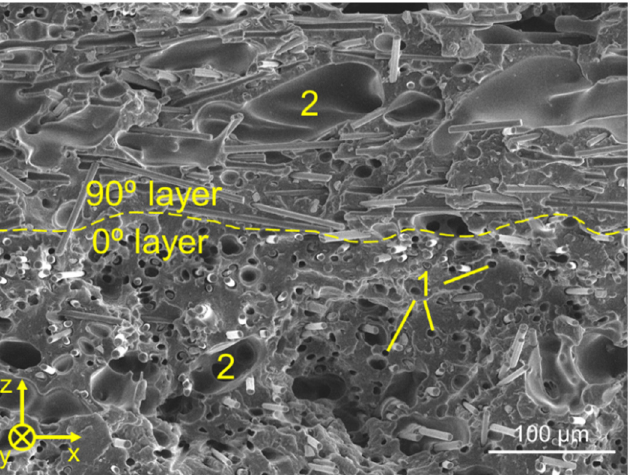
Figure 12. General appearance of fracture surfaces of 3D-printed specimens after tensile testing, with the load direction parallel to the y axis. The dashed line represents the transition between different layers; their orientation angle alludes to their respective printing directions, being relative to the y axis. Cavities caused by fiber pull-out and voids originated from filament fabrication are represented by 1 and 2, respectively.